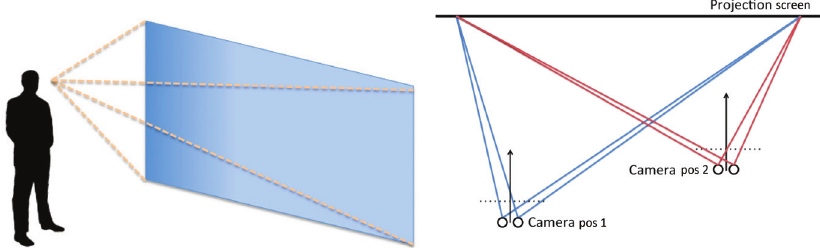
Figure 24. Head-Tracked View Frustum for Off-axis Stereoscopic Rendering. View Frustum for Stereo Rendering is Computed Based on User’s Head Position so that Application Perspective Corresponds to the Through the Window Style Immersive